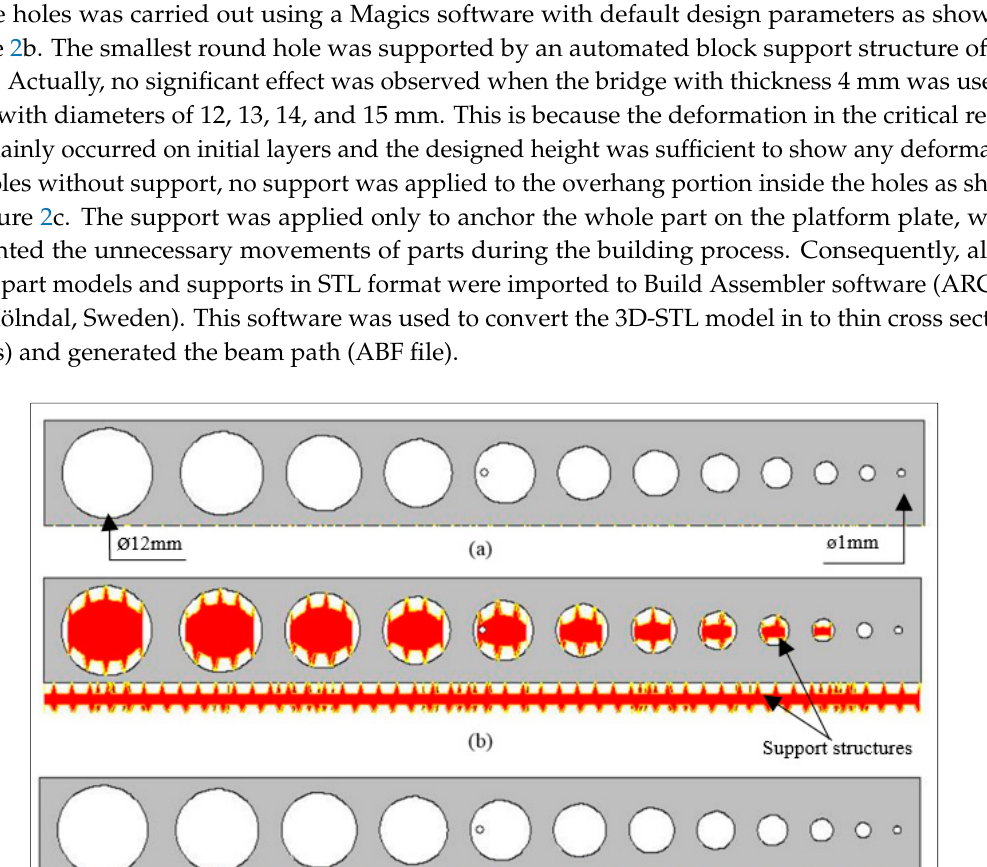
Table 1. Chemical composition of the Ti6Al4V powder.